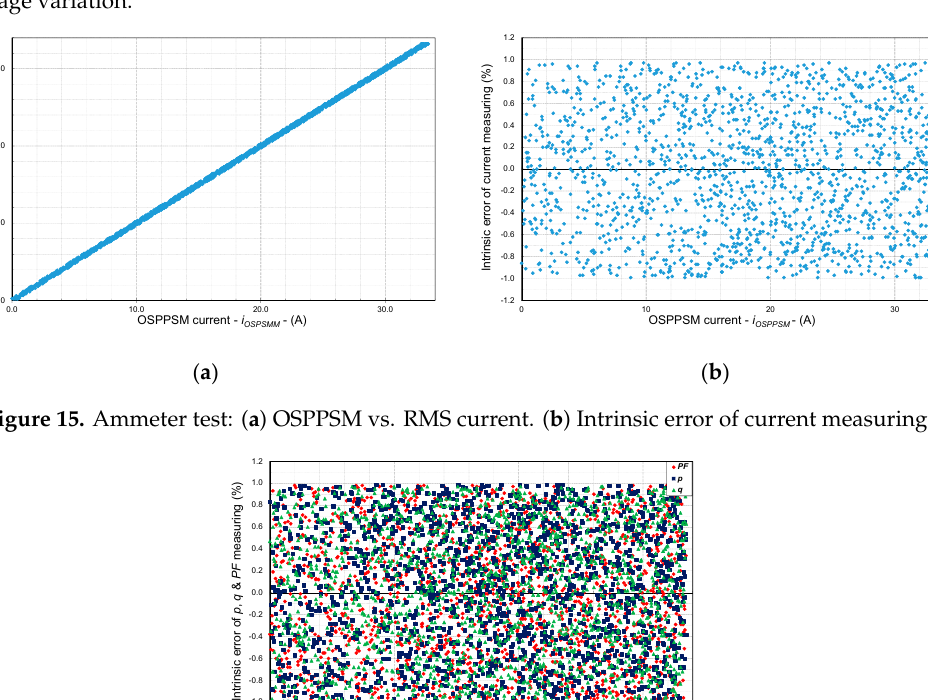
Figure 14. Ammeter test: ( a ) OSPPSM vs. RMS current. ( b ) Intrinsic error of current measuring.